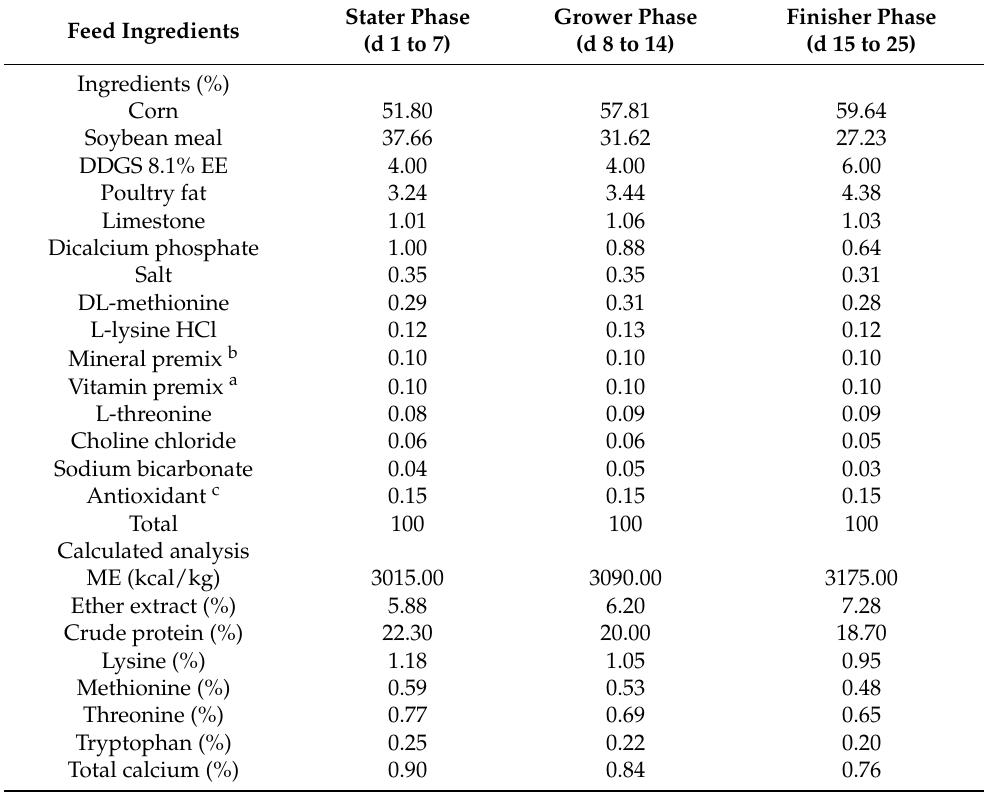
Table 1. Ingredient composition and nutrient content of the corn–soybean diet used on an as-is basis. Feed